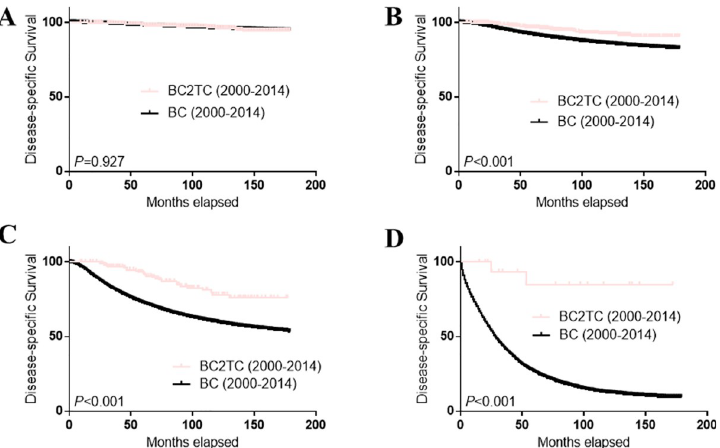
Fig 3. Comparison of DSS among different TNM stages in the BC2TC and BC groups. BC vs BC2TC for stage I (A); BC vs BC2TC for stage II (B); BC vs BC2TC for stage III (C); BC vs BC2TC for stage IV (D).